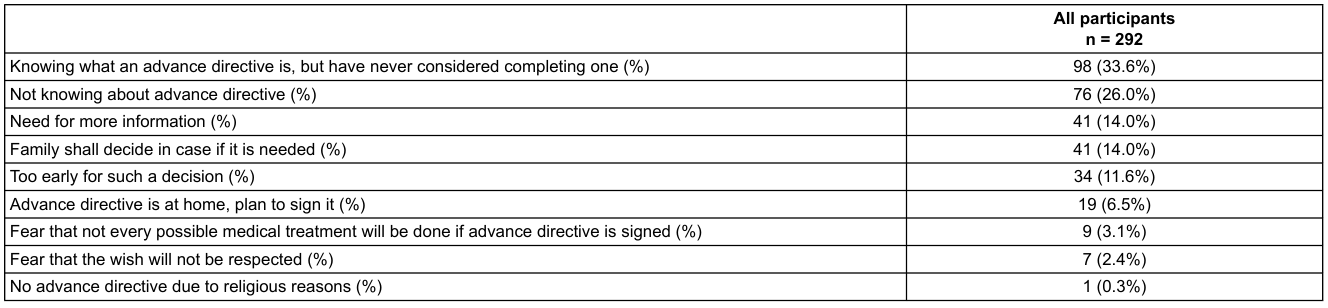
Table 3: Reasons for not having a signed advance